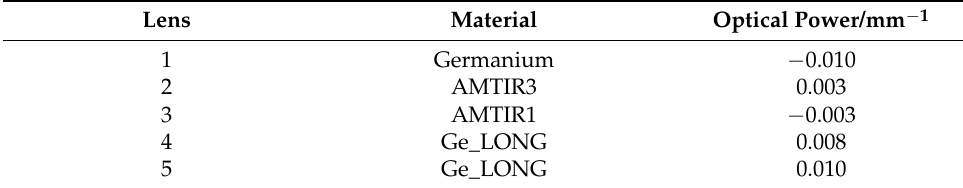
Figure 6. Optimal particle swarm distribution for 504 material combinations. Table 4. Optimal material combination and optical power distribution.